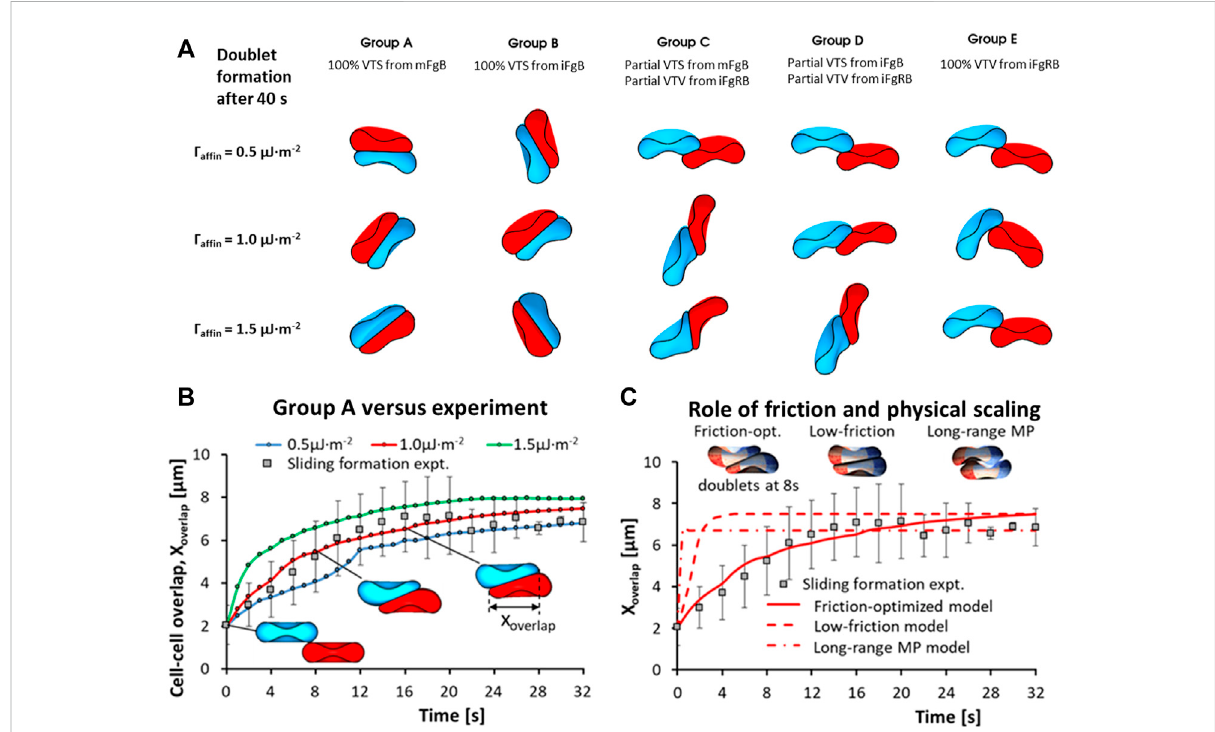
FIGURE 4 RBC-doublet formation kinematics simulations. (A) Simulation results of the doublet formation equilibrium at 40 s after initial point contact, under various adhesion af fi nity Γ affin permutations ( Simulation movie in SM1 and SM2 ); (B) Correspondence between simulation models and experiments(Khokhlovaetal.,2012)fortheVTSadhesionschemeemployedinGroupAmodelswithinthe Γ affin range0.5 – 1.5 μ J · m − 2 ,anintercellular gapseparationof20 nmandgapplasmaviscosityof3.6 cP; (C) Effectofintercellularfrictionandphysicalscalingofinteractionthelength-scale on the doublet formation rate for the Γ affin = 1 μ J · m − 2 model ( Simulation movie in SM3